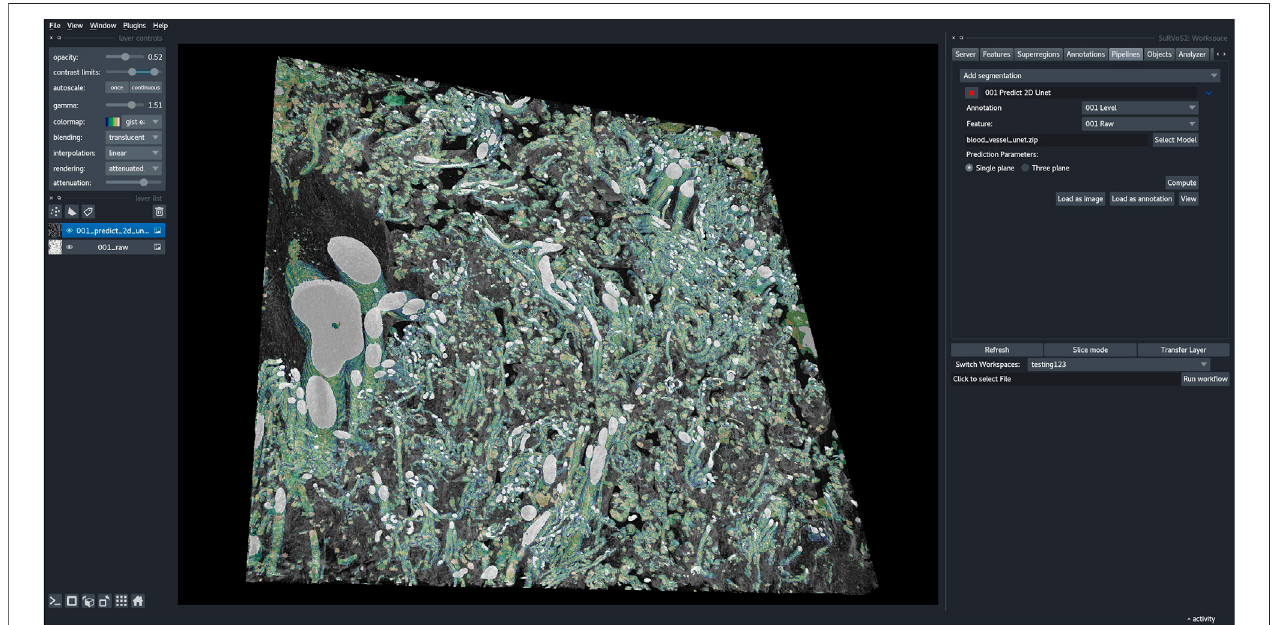
FIGURE3| SuRVoS2pluginintegratedintotheNapariviewer.TheoutputbloodvesselsegmentationsfromthedeeplearningpipelineinSuRVoS2visualizedusing the 3D rendering option and overlaid on the raw data in the Napari